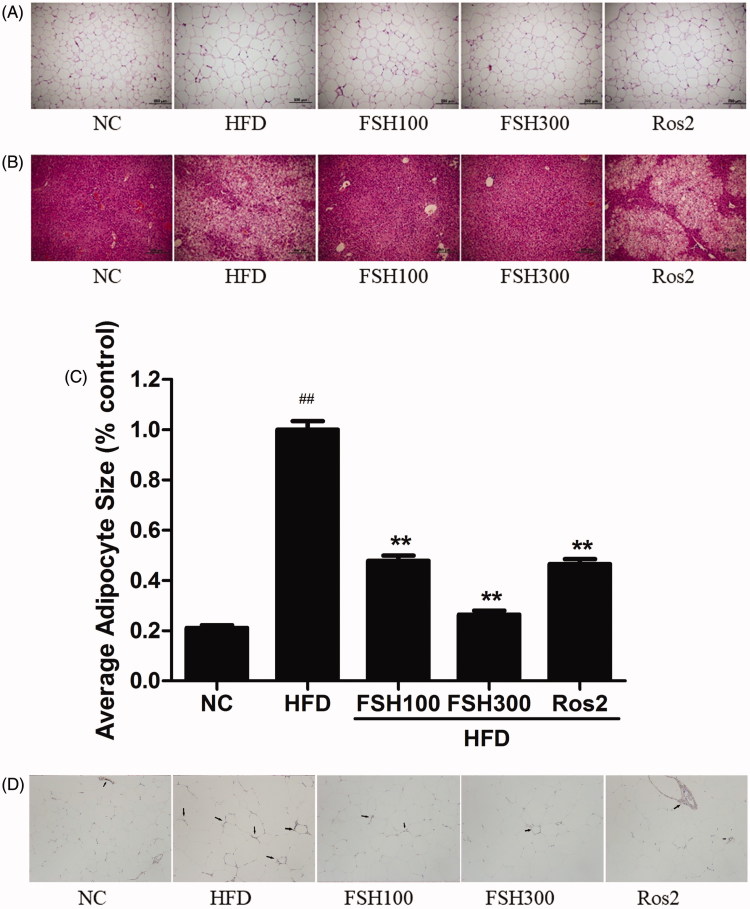
Histological analysis of epididymial WAT and liver tissue. (A) Photomicrographs of epididymal WAT stained with HE (100×). (B) Photomicrographs of liver tissues stained with HE (100×). (C) Adipocyte size (% control, n = 500; 100×). (D) Photomicrographs of epididymal white adipose tissues with F4/80 antibody. Values are expressed as mean ± S.E.M (n = 10). *p < 0.05, **p < 0.01, vs. HFD group, respectively; ##p < 0.01, vs. NC group.